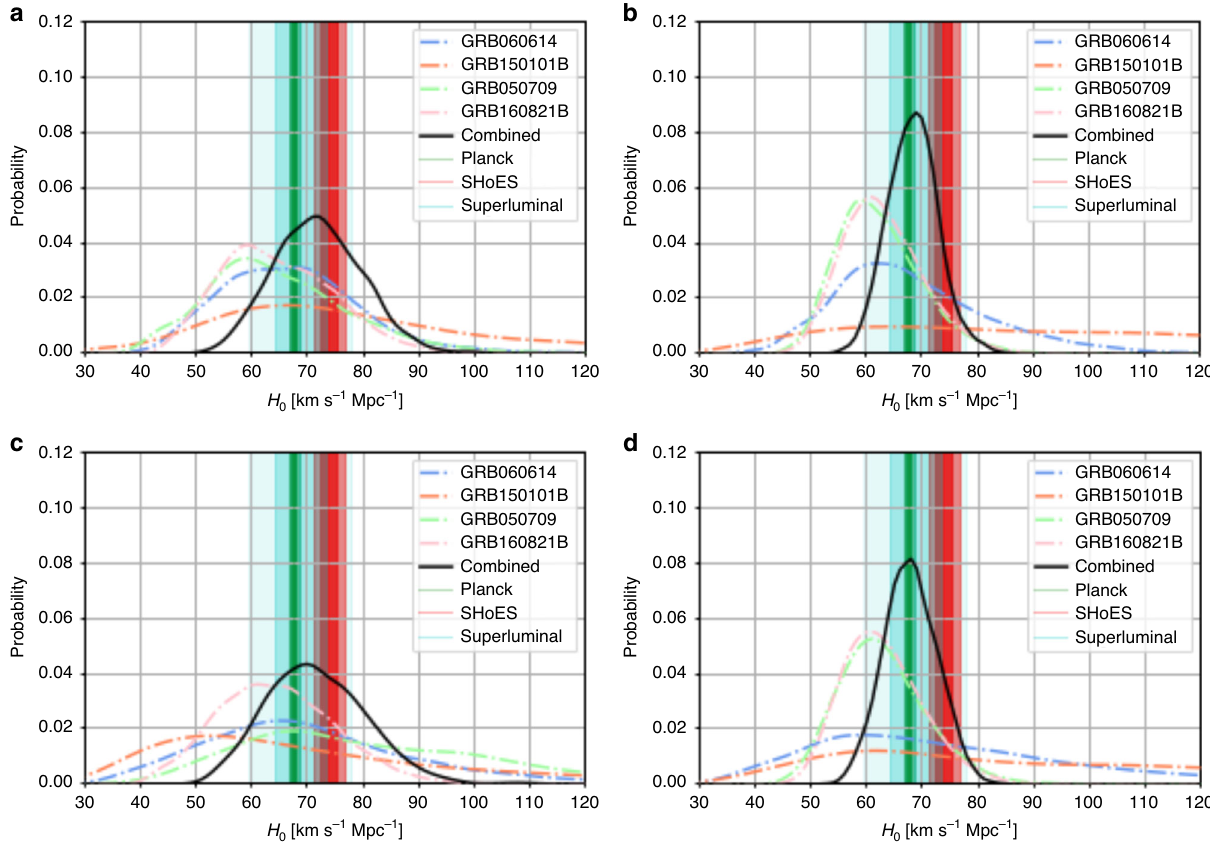
Fig. 7 Posterior distributions for H 0 for individual events without GW170817. We show them for GRB 060614, GRB 150101B, GRB 160821B, GRB 050709, and their combined posteriors are also shown. Fig. a is the Kasen 24 model with 0.1 mag errors, b is the Bulla 25 model with 0.1 mag errors, c is is the Kasen model with 0.25 mag errors, and d is is the Bulla model with 0.25 mag errors. The 1- and 2- σ regions determined by the superluminal motion measurement from the radio counterpart (blue) 16 , Planck CMB (TT,TE,EE + lowP + lensing) (green) 34 and SHoES Cepheid-SN distance ladder surveys (orange) 5 are also depicted as vertical bands.